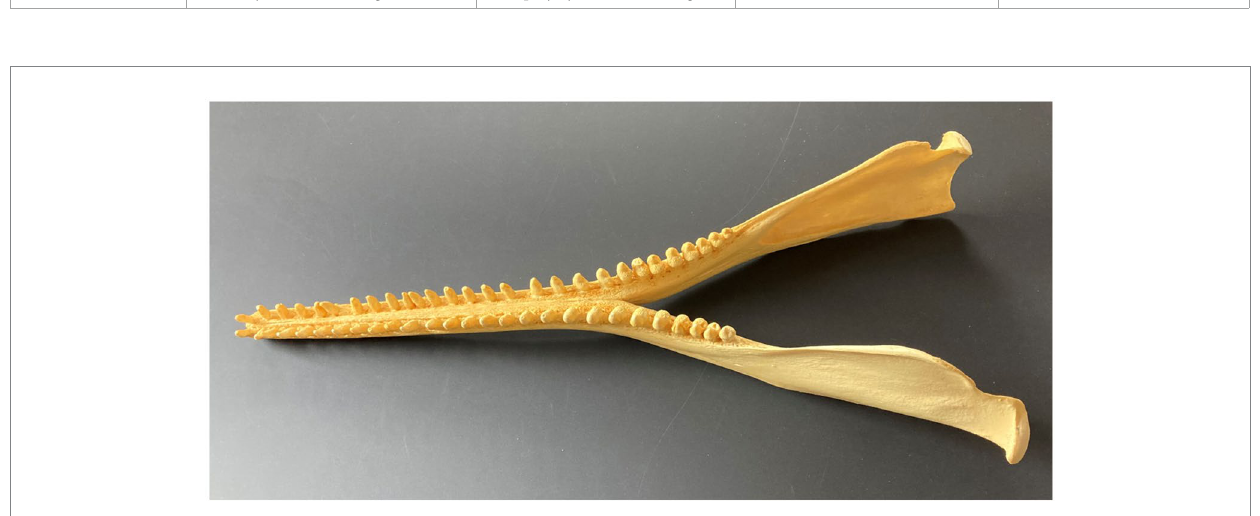
FIGURE 2 Mandible showing symphysis, coronoid process, and condyle (dorsolateral view) in Amazon river dolphin or boto, Inia geoffrensis